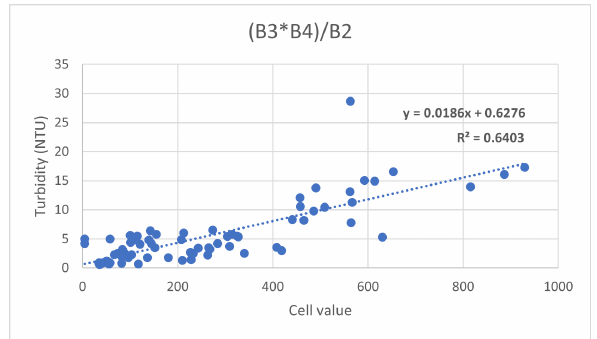
Figure 7. Correlation between the index and the turbidity measurement.